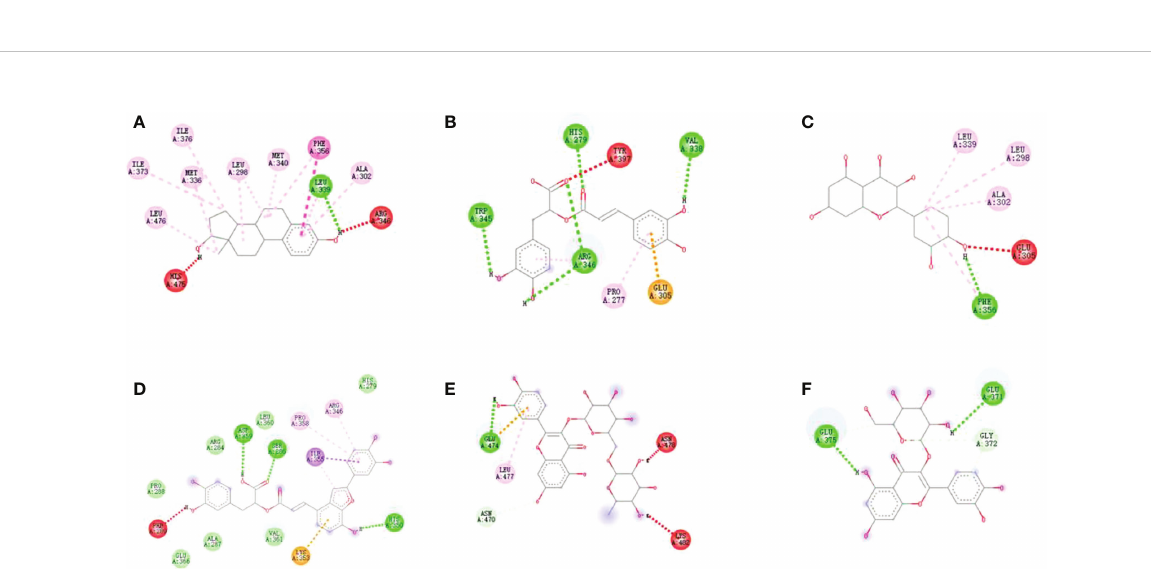
Figure 5. The kinetic parameters obtained are summarized in Table 3. The association rate constant ( K a ) and dissociation rate constant ( K d ) are parameters that express the formation rate of complex and the stability of complex, respectively. K D re fl ects the binding capacity or af fi nity; the greater the af fi nity, the smaller the K D . The results show that the K a , K d , and K D